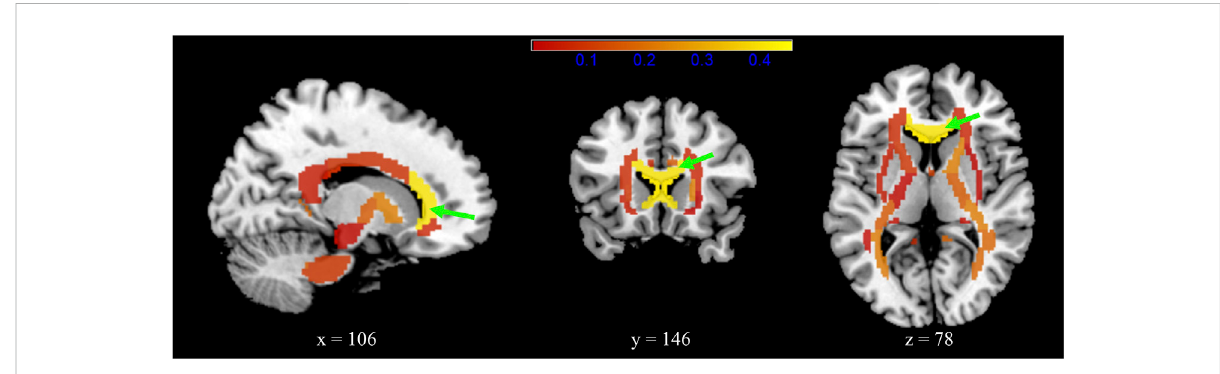
FIGURE 4 Radialdiffusivity(RD)differencesbetweenthetwosubgroupsfor48whitematterbrainregionsthatrepresentthemajorfasciculi.Thecolourbar (red – yellow) indicates the mean effect size of the group (Cohen ’ s d). The genu of the corpus callosum (green arrow) showed signi fi cantly increased RD in patients in the Cluster 2 subgroup (Cohen ’ s d = 0.405; p.adj = 0.018).